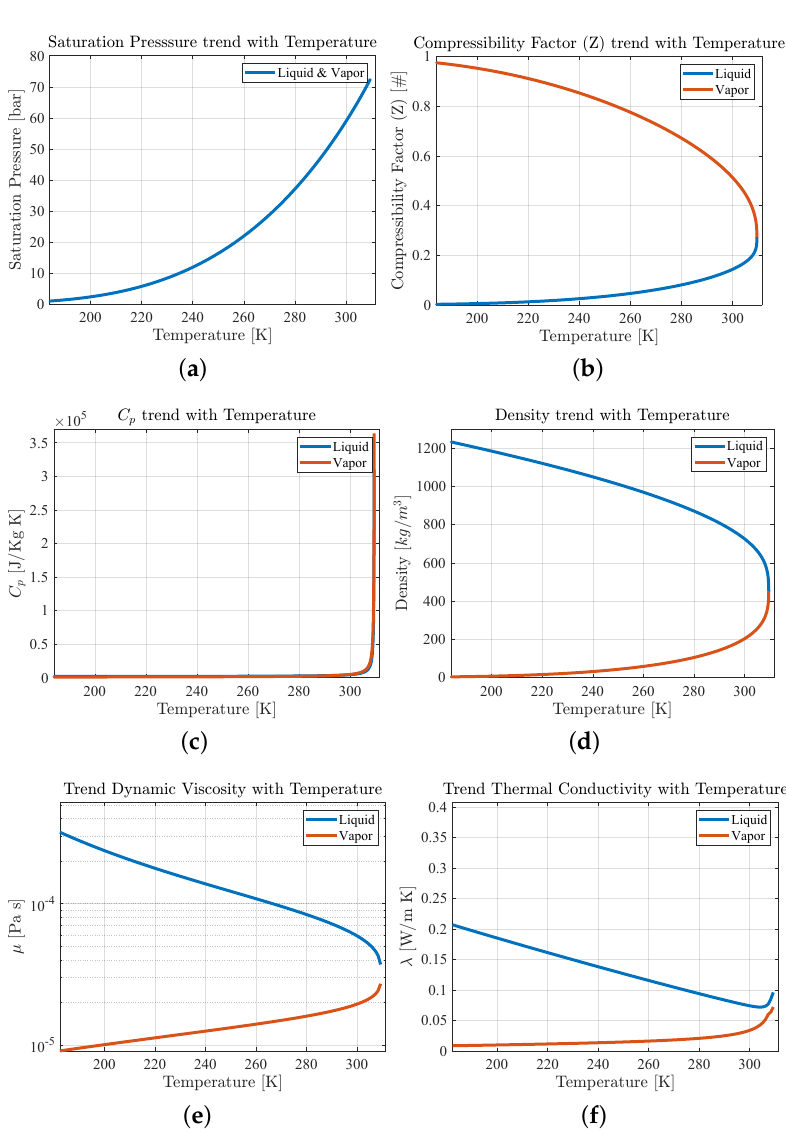
Figure 1. Trend of N 2 O transport and thermophysical properties, in saturation conditions, computed with REFPROP data [7]: ( a ) saturated pressure and temperature; ( b ) compressibility factor and temperature; ( c ) isobaric specific heat and temperature; ( d ) density and temperature; ( e ) thermal conductivity and temperature; ( f ) dynamic viscosity and